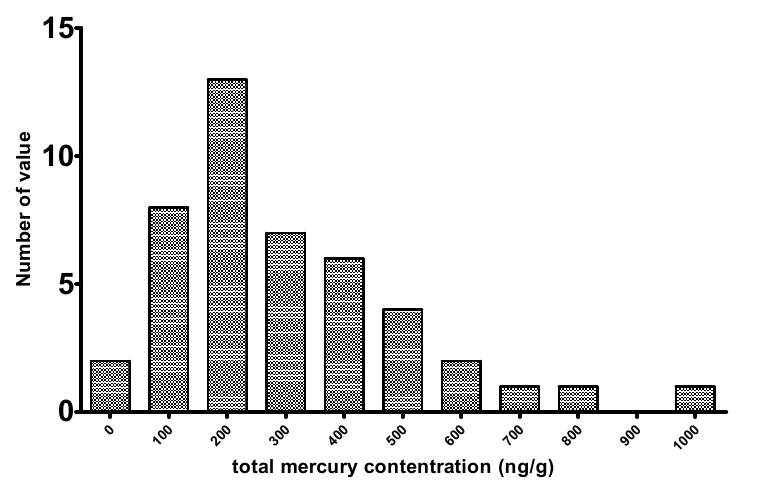
Figure 1. Frequency distribution of THg concentrations in core samples.